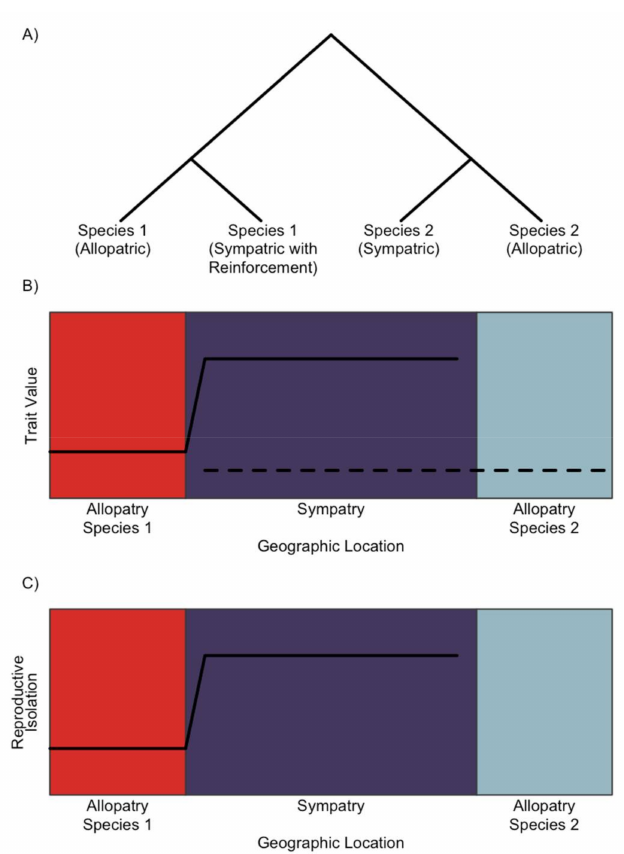
Figure 1. The phenotypic pattern of reinforcement. ( a ) A schematic of the relationship between two species each with sympatric and allopatric populations. Secondary contact between the lineages in sympatry results in costly hybridization, causing reinforcement in Species 1. ( b ) Reinforcement selects for a new reproductive trait value in Species 1 (solid line) to prevent mating with Species 2 (dashed line) in sympatry (purple). Allopatric populations of Species 1 (red) retain the ancestral phenotype. In this simplified scenario, Species 2 does not change trait value in sympatry or allopatry (blue), but in some cases Species 2 may also diverge in trait value in sympatry. ( c ) For Species 1, reinforcement increases reproductive isolation (solid line) with Species 2 in sympatry relative to